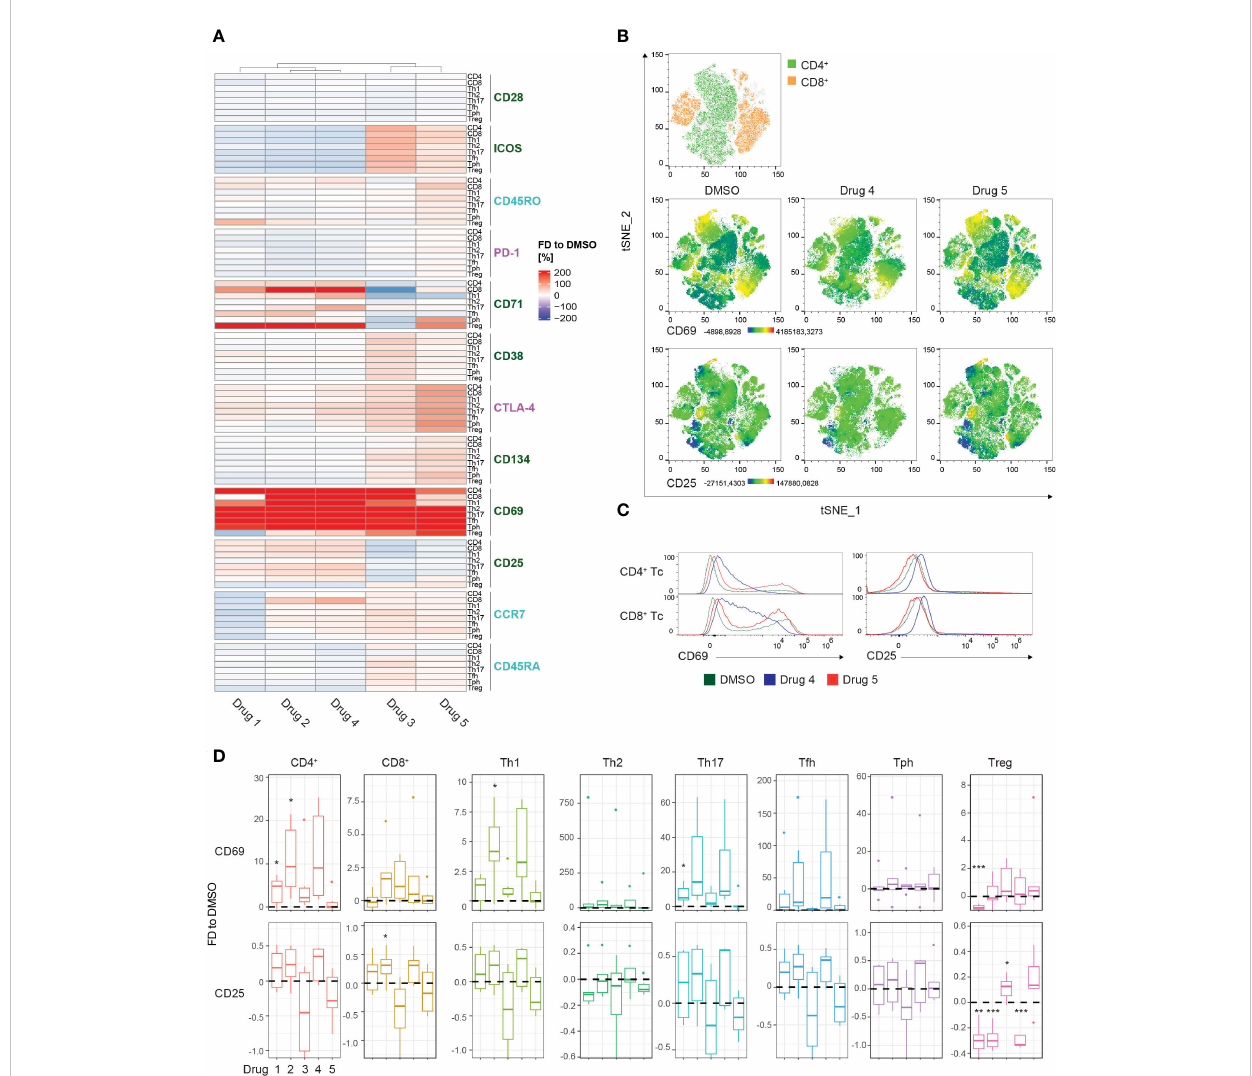
FIGURE 4 Drug screening approach for T cell subsets. (A) Summary heatmap depicting fractional differences (FD) of the marker expression as median fl uorescent intensity (MFI) of drug-treated PBMCs compared to DMSO control in the indicated T cell/Th cell subsets of 6 pooled HCs. Each column represents the individual drugs (drugs 1-5), and rows show the marker expression in the distinct PBMC compartments. Heatmaps were generated in R using the “ Complex Heatmap ” package; data are represented as the FD in percentages of the marker MFI of the individual compounds compared to DMSO and clustered by column. DMSO control was set to 0. Outliers (x<-150%, x>150%) were removed from the matrix. The color code depicts activation (green), inhibitory (purple), and maturation (turquoise) markers. (B) High-dimensional data analysis on CD3 + T cells of PBMCs from concatenated HCs using the t-Stochastic Neighbor Embedding plot (tSNE) plugin in FlowJo displaying manually gated clusters of the respective T cell subsets ( fi rst row) and density plots illustrating the global marker expression of CD69 and CD25, respectively, in the DMSO condition and in response to treatment with drug 4 and drug 5 (second and third row). Yellow-orange colors depict areas of high marker expression, whereas dark green-blue areas indicate areas of lower marker expression. (C) Histograms showing CD69 and CD25 expression, respectively, in the indicated T cell/Th cell subsets. Colors illustrate the treatment condition, as DMSO is green, drug 4 treatment is blue and drug 5 treatment is red. (D) Summary box plots showing the FD of the marker MFI of drugs 1-5 compared to DSMO in the indicated T cell/Th cell subsets. The intercept line equates to DMSO control. (*P < 0.05, **P < 0.01, and ***P < 0.001) (A – D) Data are representative (C) or show a summary (A, B, D) of at least 6 independent experiments. Th, T helper; Treg, regulatory T cells; Tfh, T follicular helper and Tph, T peripheral